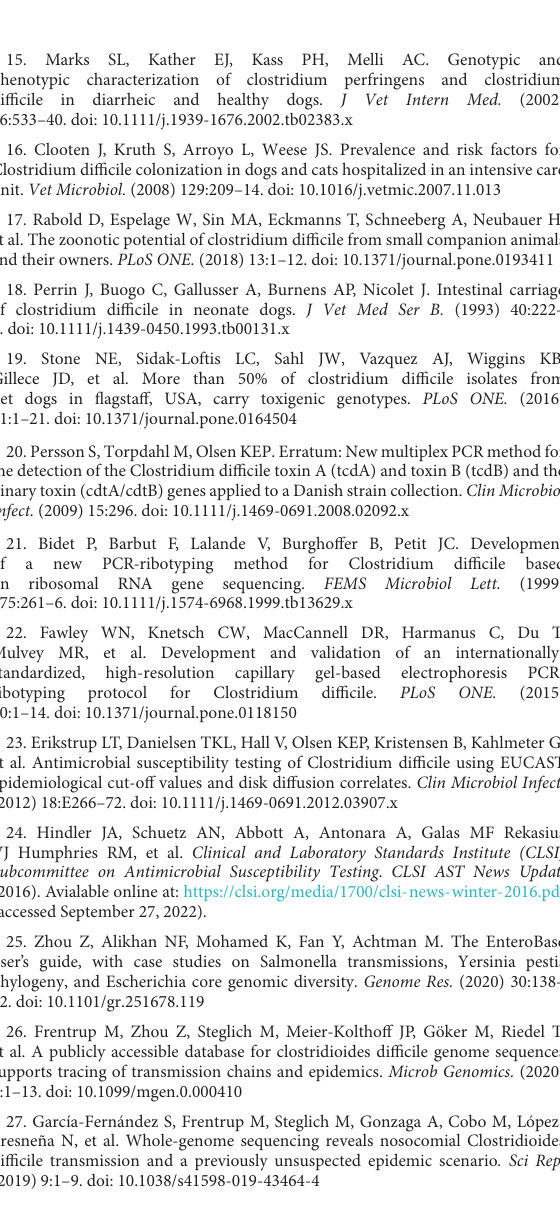
SUPPLEMENTARYFIGURES1 Percentage prevalence by year of Clostridioides difficile ribotypes from human clinical infections over an 8-year period (2014–2021) in Portugal. Other = all other ribotypes with prevalence <